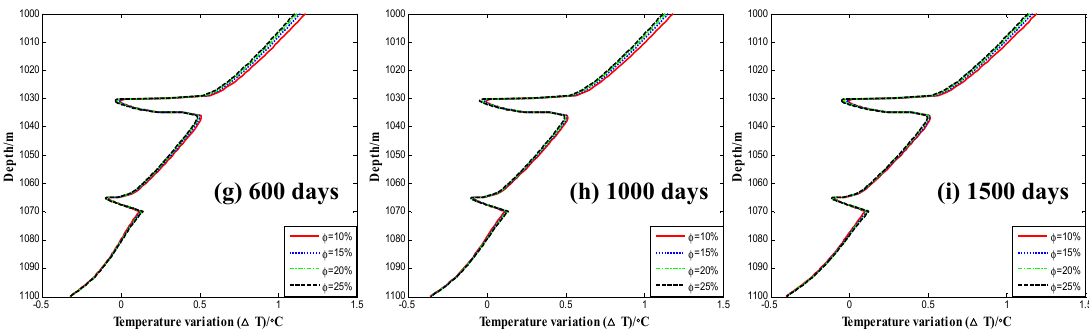
Figure 19. Formation temperature variation at the wellbore-formation interface (r = 0.14 m, 1000 m ≤ z ≤ 1100 m) with a different porosity ( ∅ ). ( a )–( i ) represent the temperature profiles from 1 day to 1500 days.